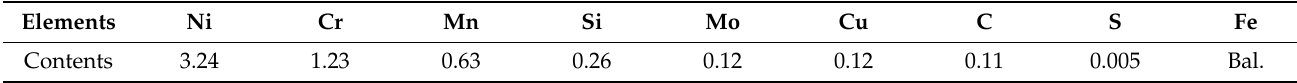
Figure 1. Schematic of ( a ) the metallographic organization and ( b ) the surface XRD analysis of AISI 9310 steel. Table 1. Chemical composition of AISI 9310 steel (wt.%). Table 1. Chemical composition of AISI 9310 steel (wt.%).